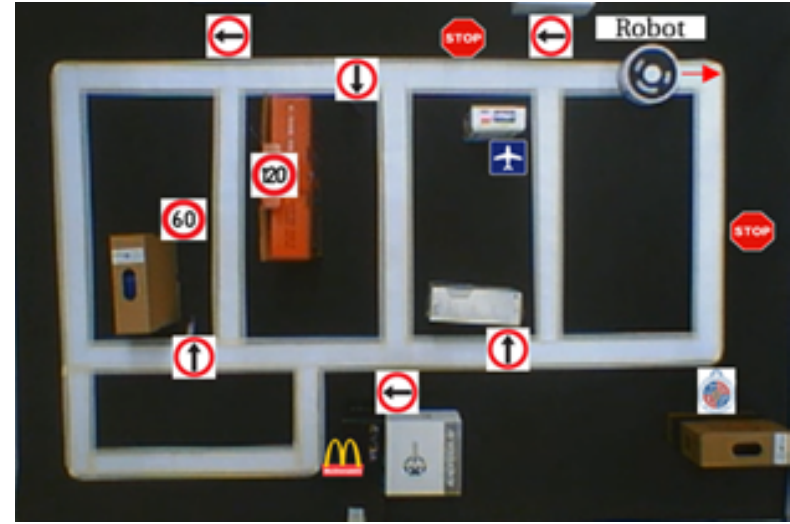
Figure 14. Experimental detection of traffic signals in a real